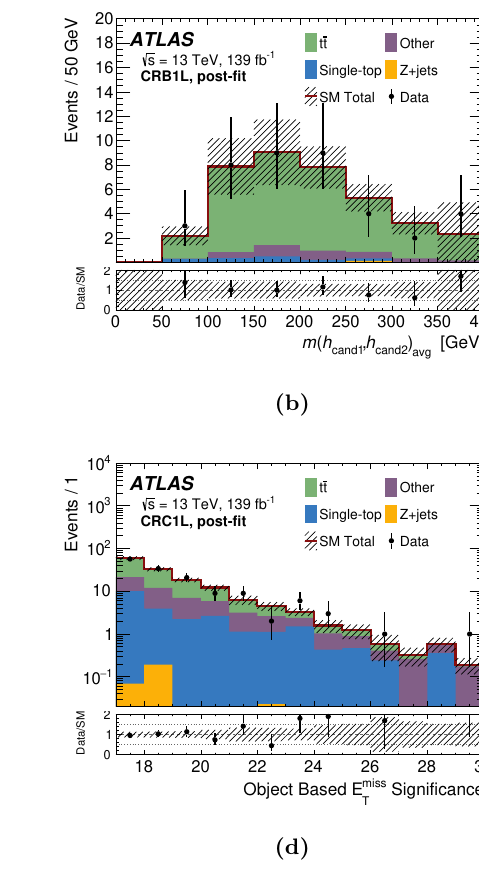
~ E miss Figure 4. Distributions of (a) m ( h cand ) in CRA1 ‘ , (b) m ( h cand1 ; h cand2 ) avg in CRB1 ‘ , (c) T in CRC2 ‘ , and (d) S in CRC1 ‘ after the background-only (cid:12)t; ratios of data to SM predictions are reported in the bottom panels. All uncertainties as de(cid:12)ned in section 7 are included in the uncertainty bands of the top and bottom panels in each plot. The backgrounds which contribute only a small amount (diboson, W +jets and t (cid:22) t + W=Z=h ) are grouped and labelled as ‘Other’. Over(cid:13)ow events which do not fall into the axis range are placed into the rightmost